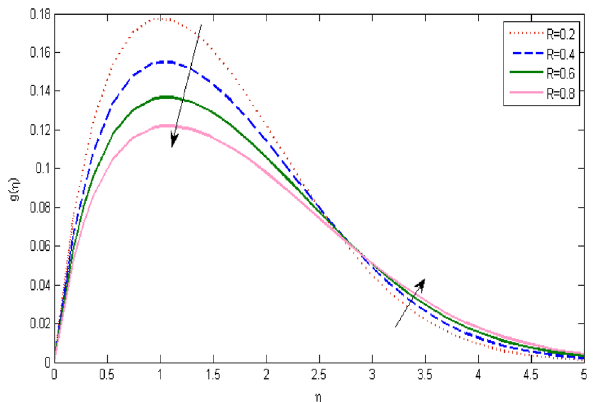
Figure 11. influence on g .